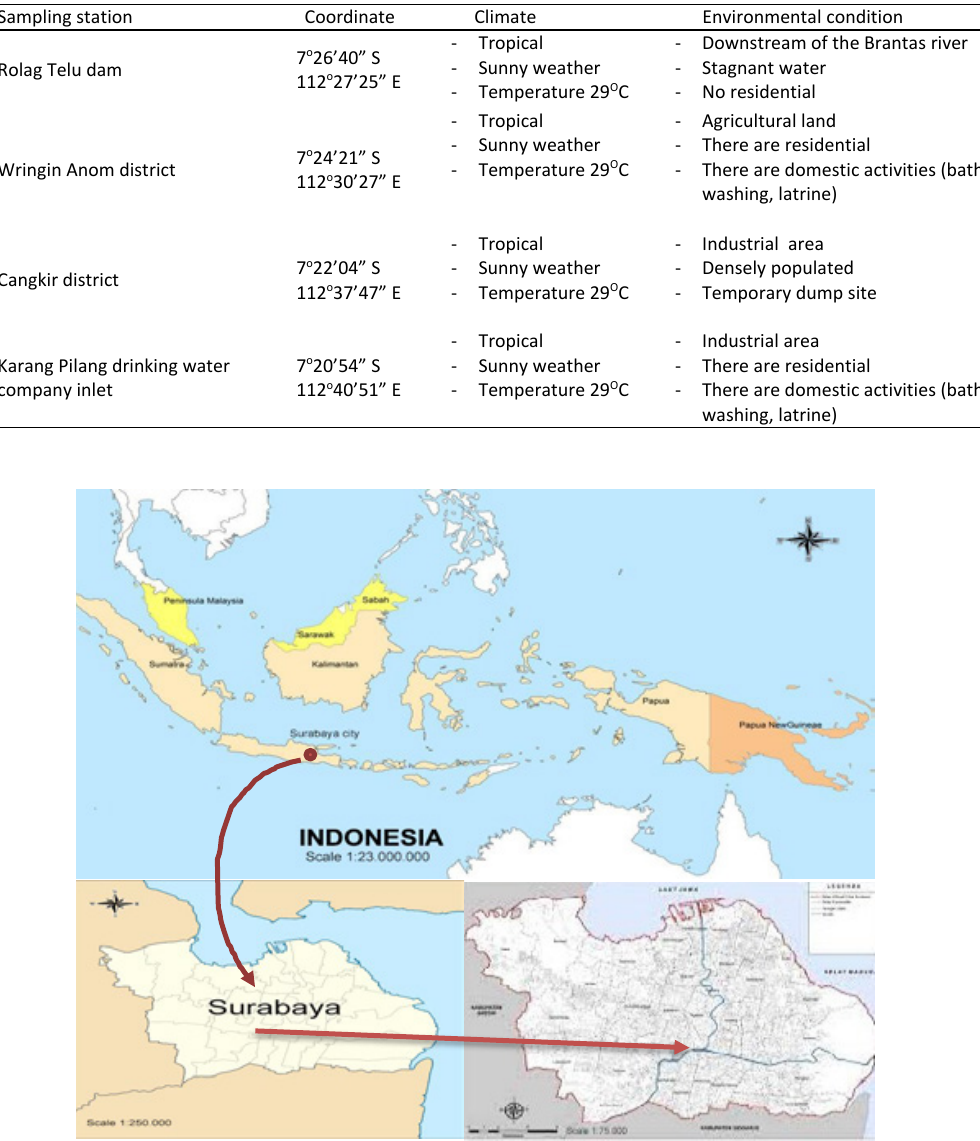
Fig. 1: Geographic location of the study area in the Kali Surabaya River, Indonesia